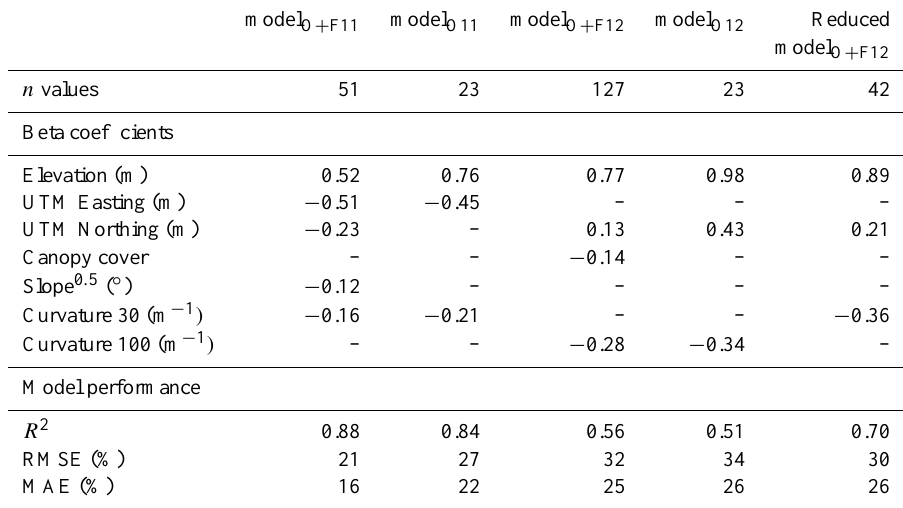
Table 5. Beta coefficients (standardized coefficients) and performance statistics for each multiple regression model with dependent variable SWE (mm). Each coefficient included in the models was statistically significant ( p value<0.05). Model performance metrics are evaluated against the entire data set (both operational and field) for each year. RMSE and MAE statistics are reported as standardized values (value of the statistic divided by the mean of the